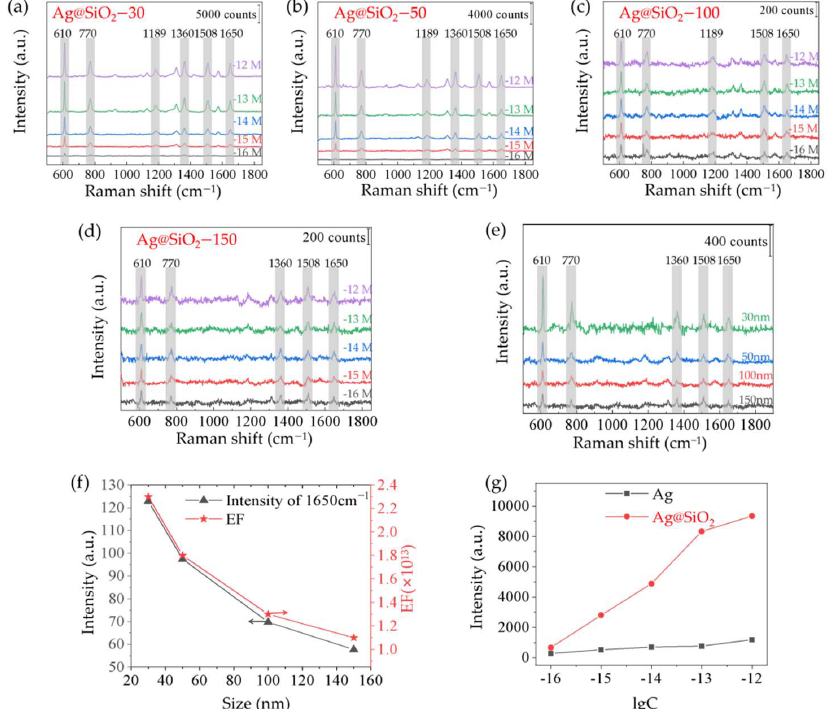
Figure 5. Raman measurements for R6G with different concentration on absorbed on samples with AgNPs diameter of ( a ) 30 nm; ( b ) 50 nm; ( c ) 100 nm; ( d ) 150 nm; ( e ) Raman intensity of 10 −16 mol/L R6G on different samples; ( f ) Raman intensity 1650 cm −1 of 10 −16 mol/L R6G and the corresponding EF of different samples with different Ag sizes; and ( g ) Raman intensity of 10 −16 mol/L to 10 −12 mol/L absorbed on our Ag@SiO 2 and Ag on